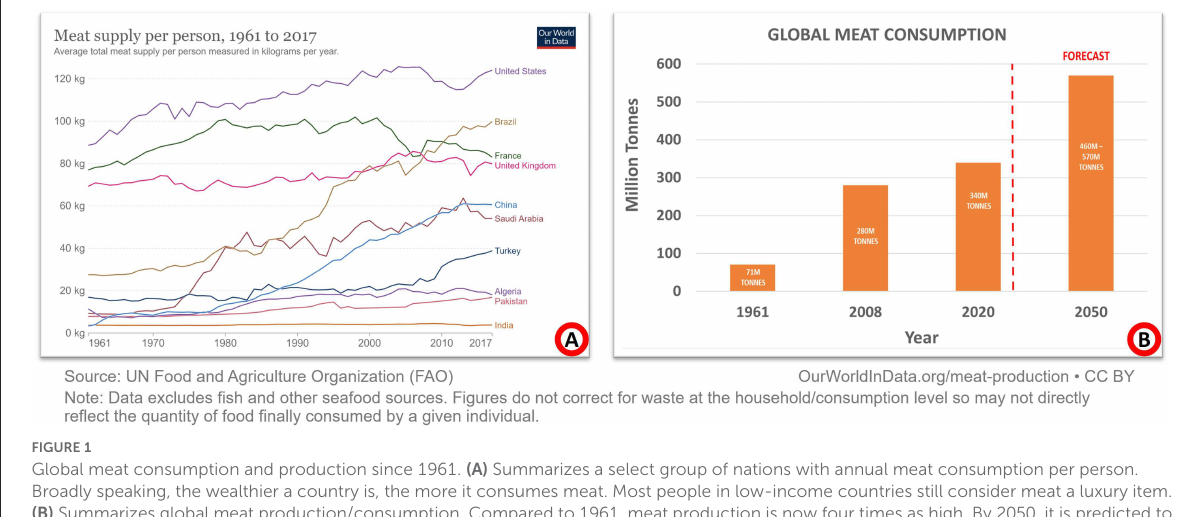
FIGURE1 Global meat consumption and production since 1961. (A) Summarizes a select group of nations with annual meat consumption per person. Broadly speaking, the wealthier a country is, the more it consumes meat. Most people in low-income countries still consider meat a luxury item. (B) Summarizes global meat production/consumption. Compared to 1961, meat production is now four times as high. By 2050, it is predicted to rise to between 460 and 570 million metric